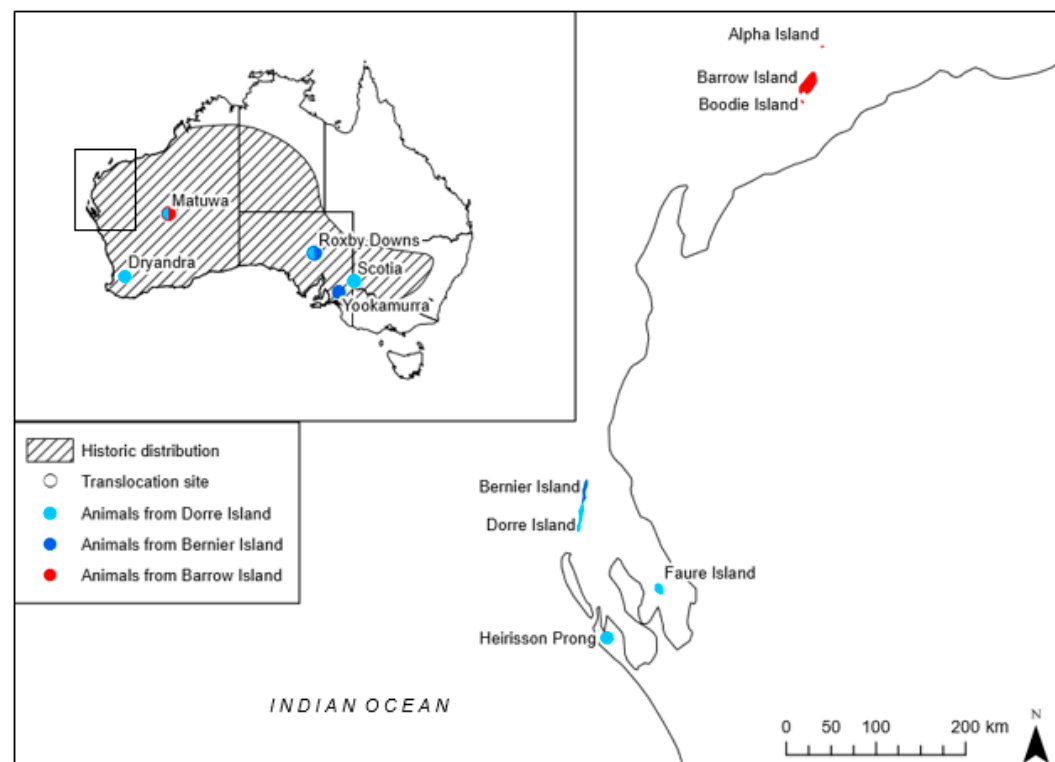
Figure 1. Location of natural and translocated populations of Bettongia lesueur within its historic distribution (adapted from Short & Turner [38]). Source population origin for each translocation is indicated where (cid:8) represents individuals from Dorre Island (Shark Bay subspecies B. l. lesueur ), (cid:8) represents individuals from Bernier Island (Shark Bay subspecies B. l. lesueur ) and (cid:8) represents individuals from Barrow Island (Barrow Island subspecies B. lesueur unnamed subspecies). Translocated populations with admixing show two colors; Roxby Downs admixed from the two Shark Bay populations and Matuwa admixed from the two subspecies.